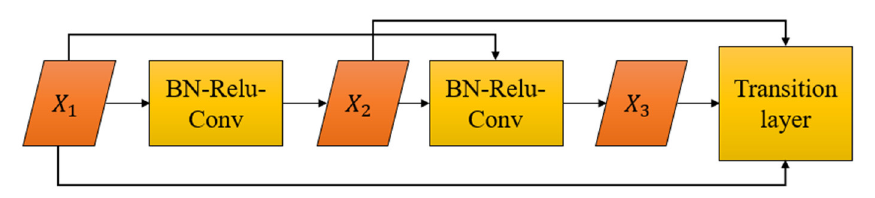
Figure 4. Dense blocks.